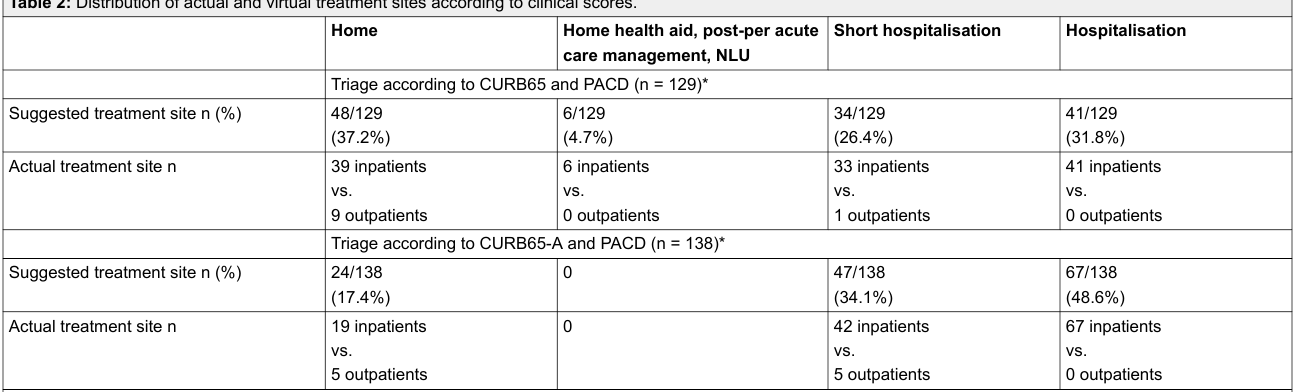
Table 2: Distribution of actual and virtual treatment sites according to clinical